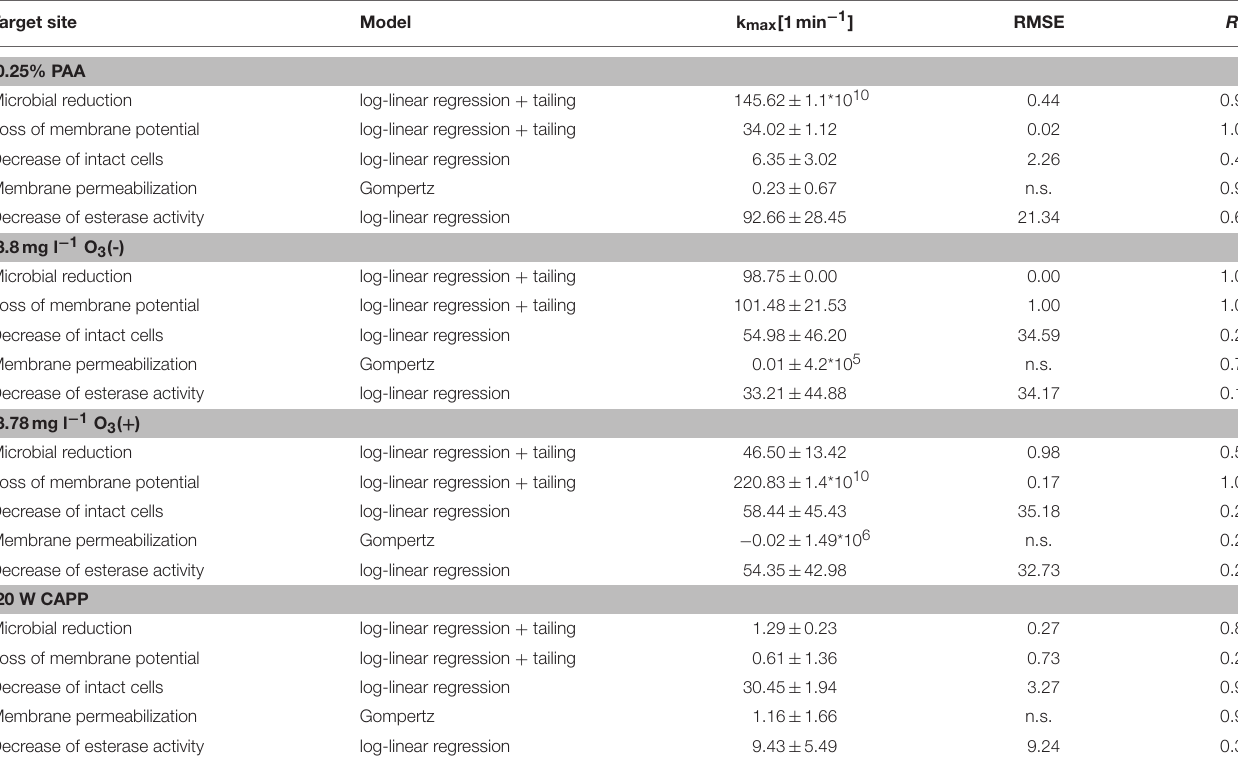
TABLE 4 | Statistical measures and parameter values obtained from GInaFit Version 1.6 and SigmaPlot13 for experimental data of inactivated E.